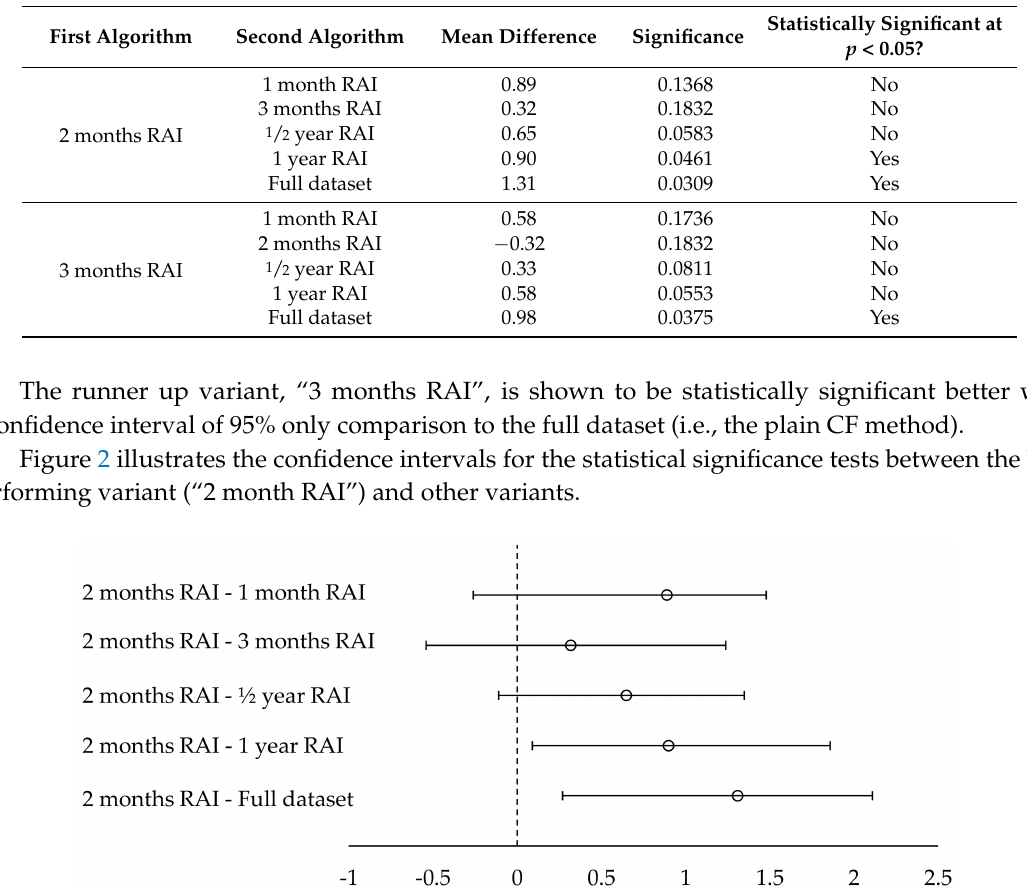
Figure 2. 95% confidence intervals for the statistical significance tests between the best performing variant (“2 month RAI”) and other